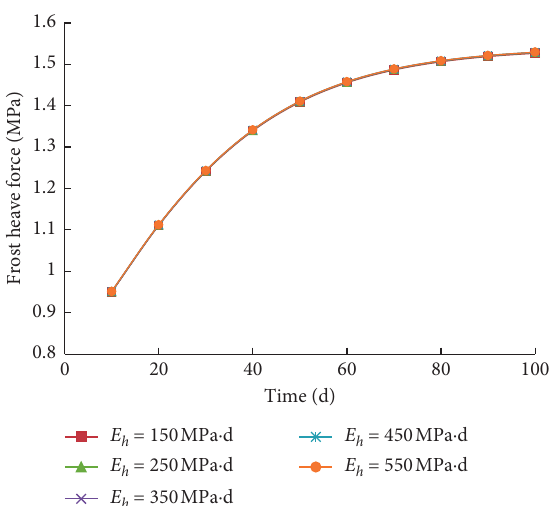
Figure 5: Frost heaving force-time curve under different sur- rounding rock elastic modulus E h .